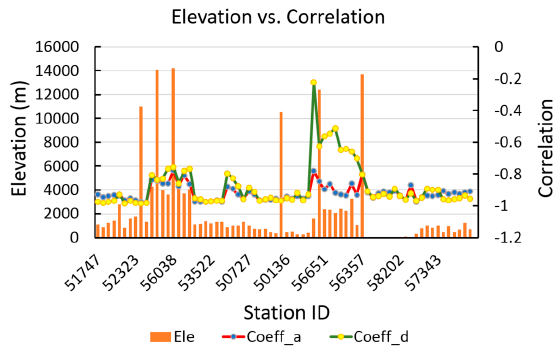
Figure 7. Correlation of the MODIS LST and FTI derived by microwave observations from 70 randomly-selected stations at different elevations. Ele is the elevation of the stations; Coeff_a is the correaltion at 13:30; Coeff_d is the correlation at 1:30.